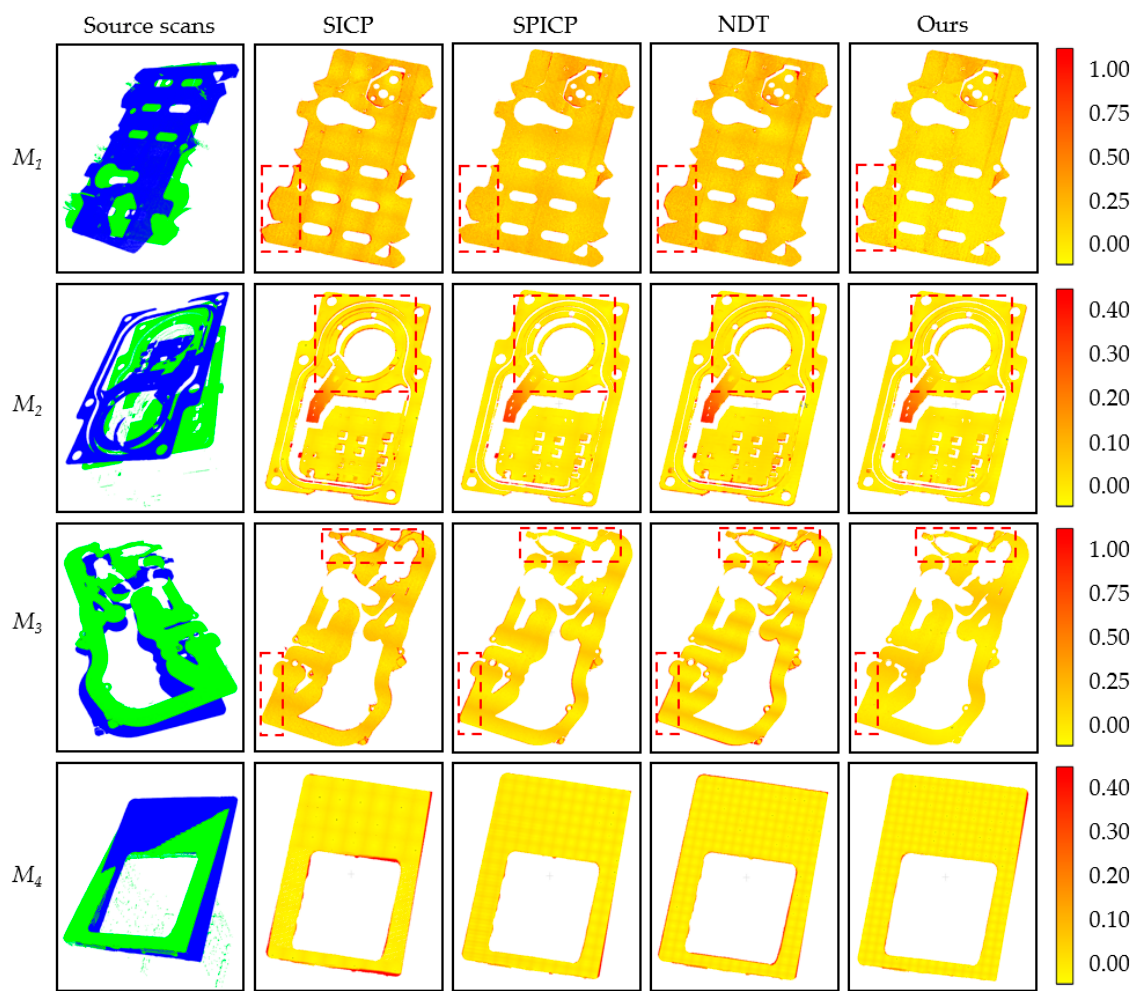
Figure 10. Registration results of the four measured models with the four registration methods (SICP, SPICP, NDT, and Ours). The first column shows the two source scans for each model. The registration error for each model is measured by the change of color according to the color bar, and the measurement unit is mm.